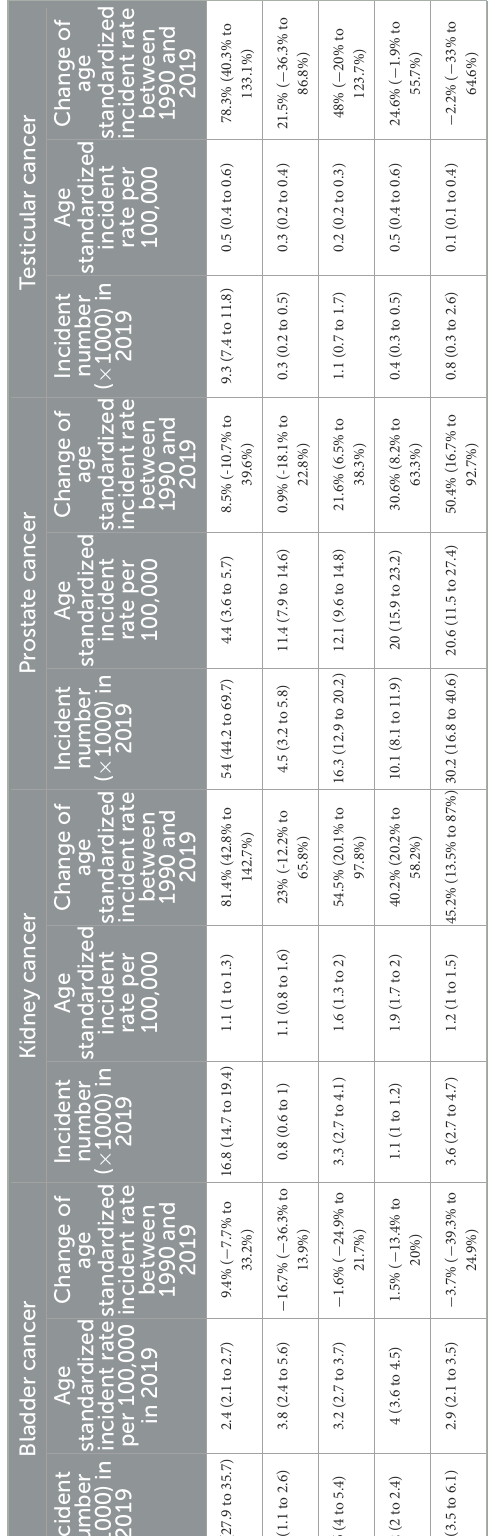
(Figure 6; Supplementary Figures 10S, 11S). Globally, smoking- related deaths gradually decreased for the three cancers, but other risk factors related to death and DALYs increased for bladder and kidney cancer, indicating the important role of metabolic health in the management of bladder and kidney